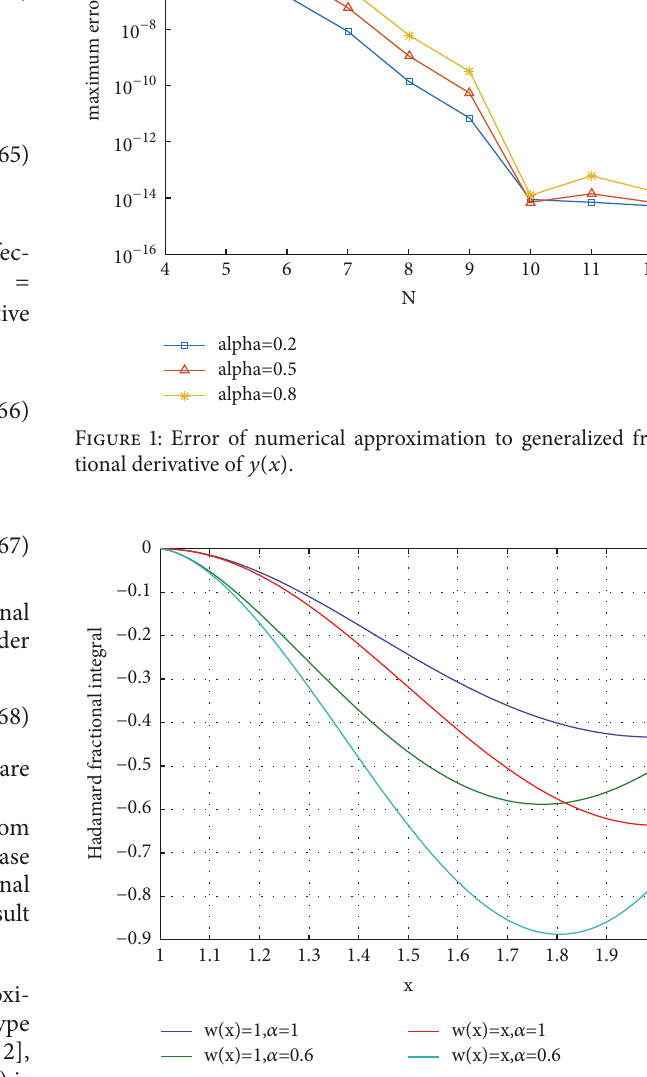
Figure 2: Hadamard fractional integral for different weight 𝑤(𝑥) and 𝛼